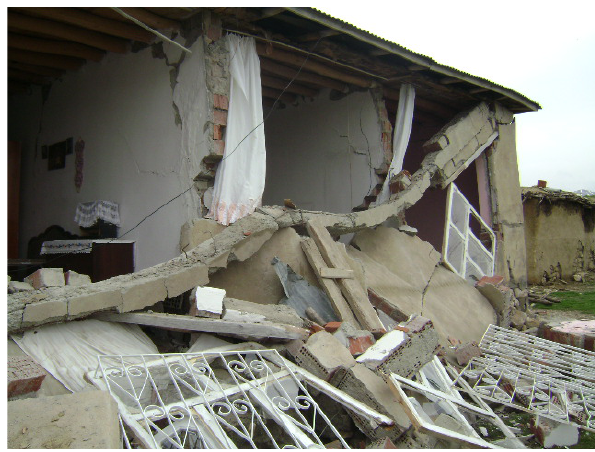
Fig. 10. Out-of-plane failure due to long span.